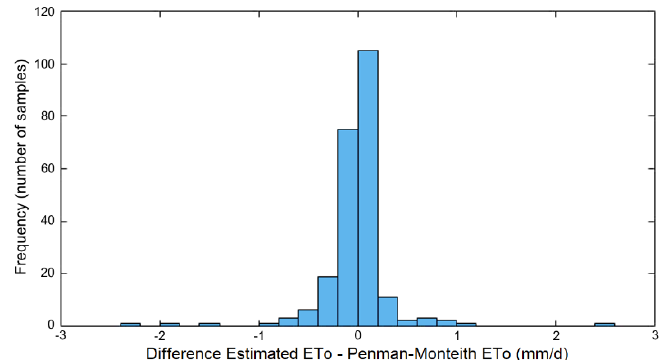
Figure 7. Error histogram of the RFC + K* regression model in the estimation of ETo.